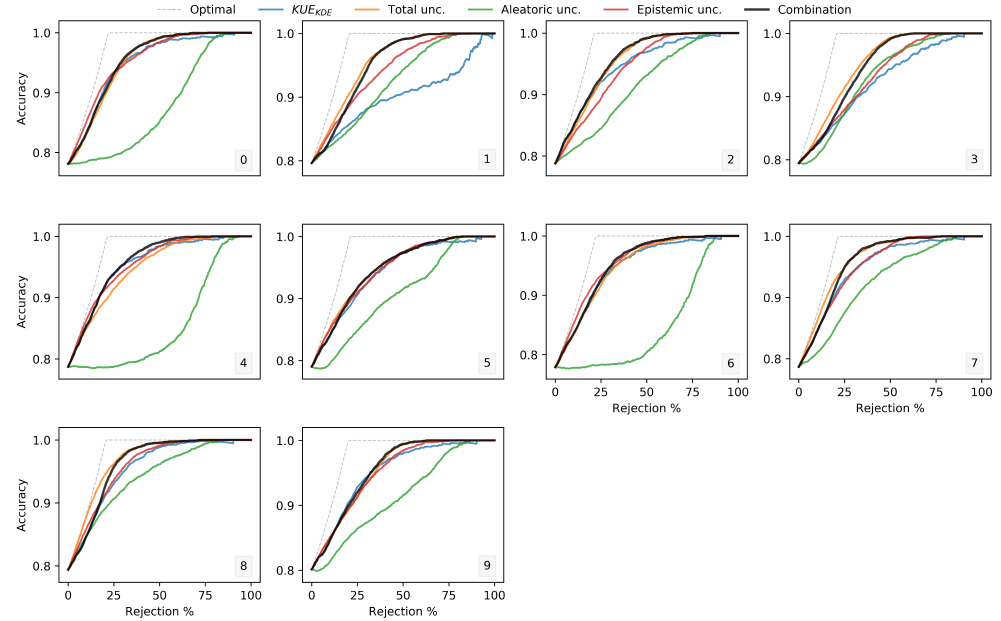
Figure A2. AR curves for aleatoric, epistemic and total uncertainty for the Digits dataset. The curve for perfect rejection is included as a baseline. The name in each plot represents the digits used for each OOD input combination.